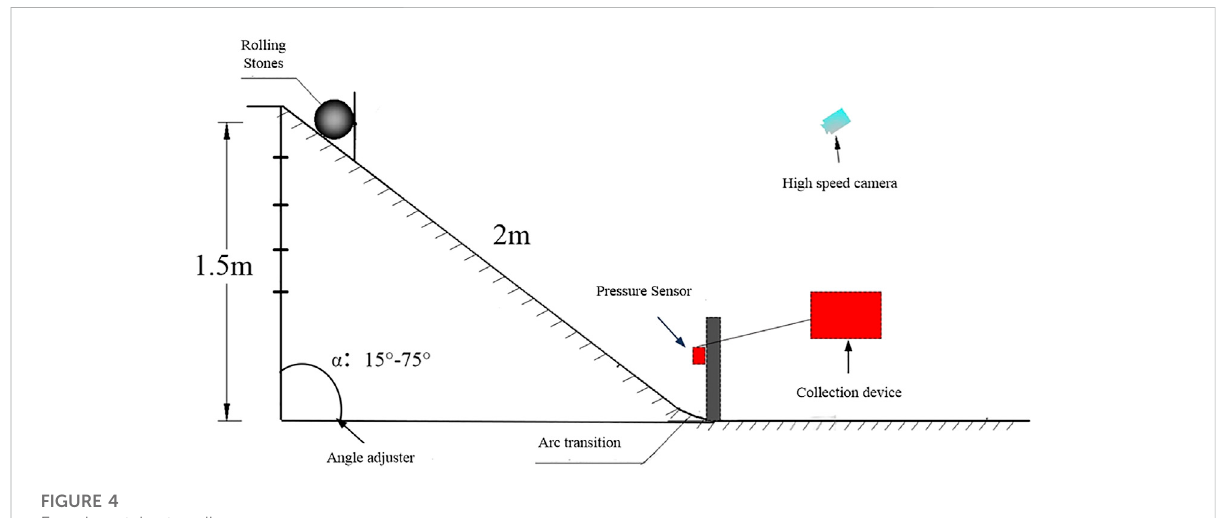
FIGURE 4 Experimental setup diagram.